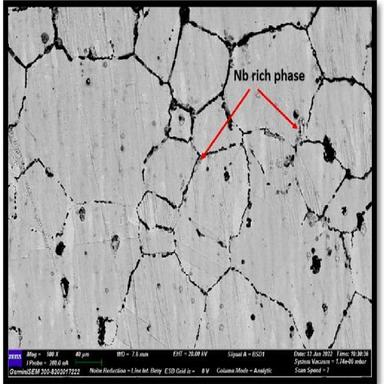
SEM image of joint region showing Nb rich phase.